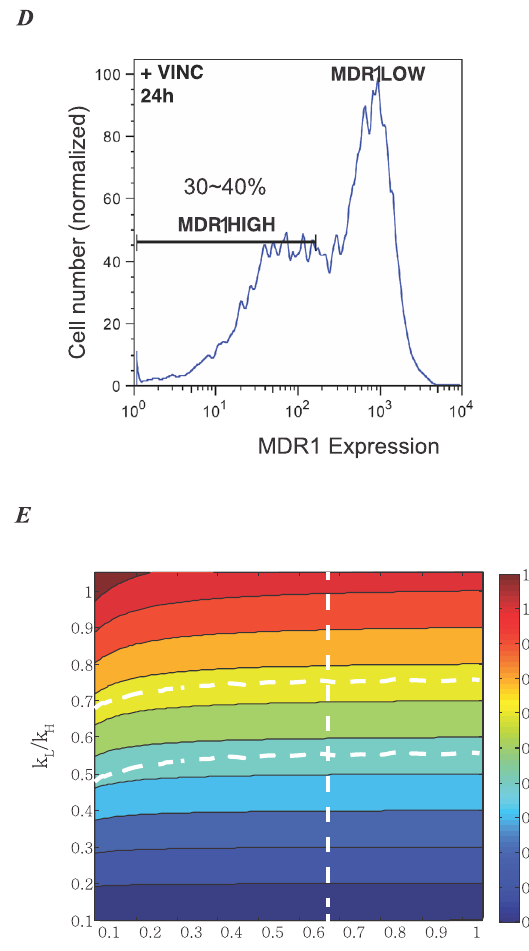
Figure 3. HL60 cell population dynamics. Leukemia cell line HL60 has two subpopulations, MDR High and MDR Low , based on their abilities to retain CalceinAM fluorescent dye (flow cytometry profiles), as measured by flow cytometry. The flow cytometry histograms correspond to a snapshot of the cell population at a given time point. In this particular case the parameter is the accumulation of a fluorescent dye, CalceinAM, which works as a surrogate for ABC transporters activity and multidrug resistance: if the cells retain the dye, ABC transporters are not active and the cell is sensitive to drug; if the cells do not accumulate the dye, ABC transporters are active and the cell is resistant to drug treatment. A . In the absence of drug the two subpopulations co-exist at a stable cell ratio, MDR High 5 2% and MDR Low 5 98%. B . When the cells are treated with 10 nM of vincristine for 72 h the proportions change to MDR High 5 40% and MDR Low 5 60%. For further details please refer to Pisco et al